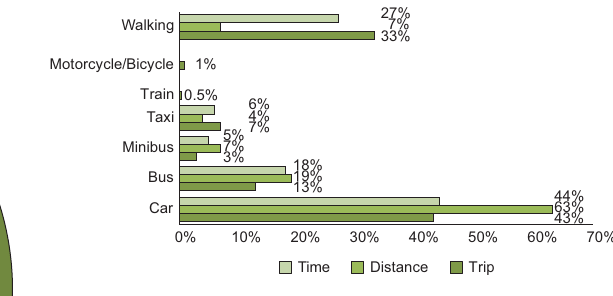
Fig. 4. Time, distance and number of trips based on the type of transportation (travel modes).